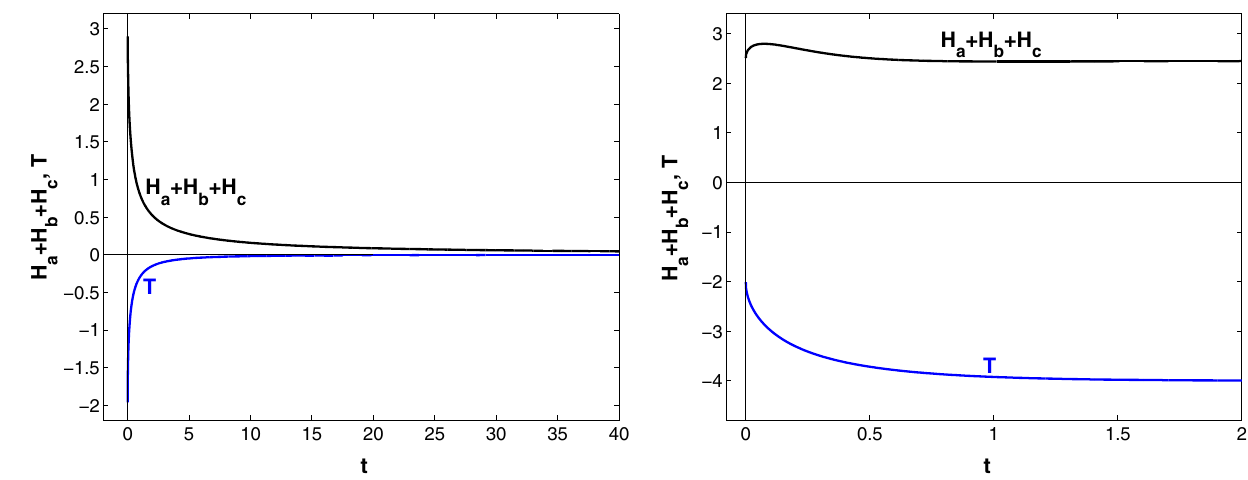
Fig. 2 The evolution of the torsion scalar T and sum of Hubble param- plot and H a ( 0 ) = − 0 . 24, H b ( 0 ) = 0 . 9, H c ( 0 ) = 1 . 85 for the right eters X = H a + H b + H c for N = 2, f 0 = 1 one. The left picture demonstrates the cosmological scenario Ia and the , w = 0, K = 1. The 12 right graph shows the scenario Ib initial values are H a ( 0 ) = − 0 . 4, H b ( 0 ) = 1, H c ( 0 ) = 2 . 3 for the left